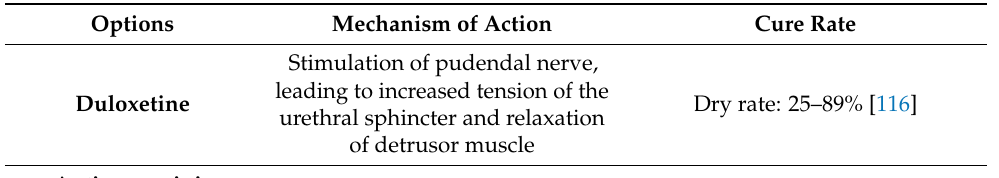
Table 1. Mechanism of action and cure rate of medical treatment options for